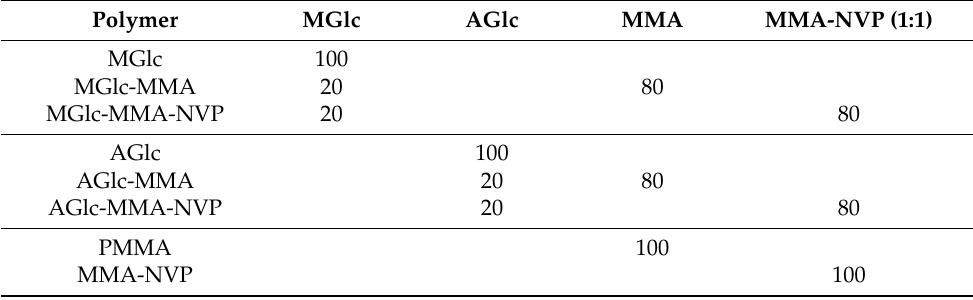
Table 1. Chemical composition (%) of the glucose-derived polymers.